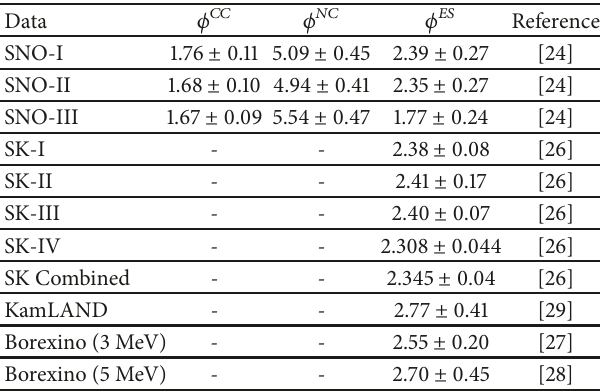
Table 1: Solar neutrino flux measured by various experiments in units of 10 6 cm −2 s −1 .